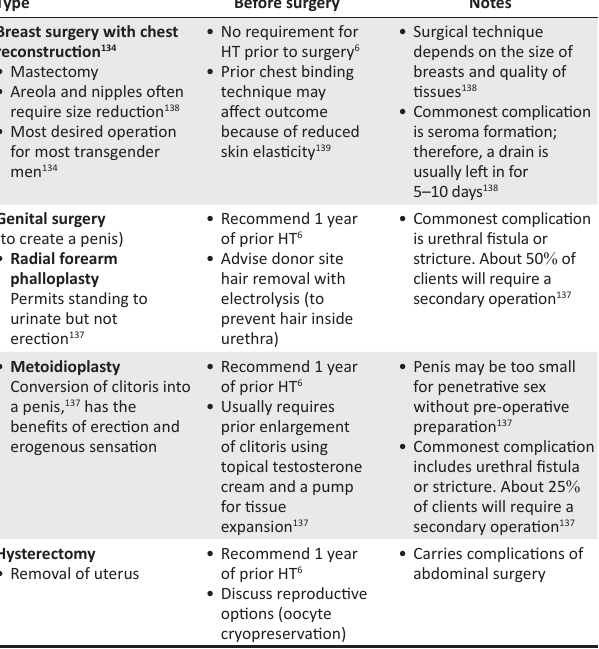
TABLE 10: Masculinising